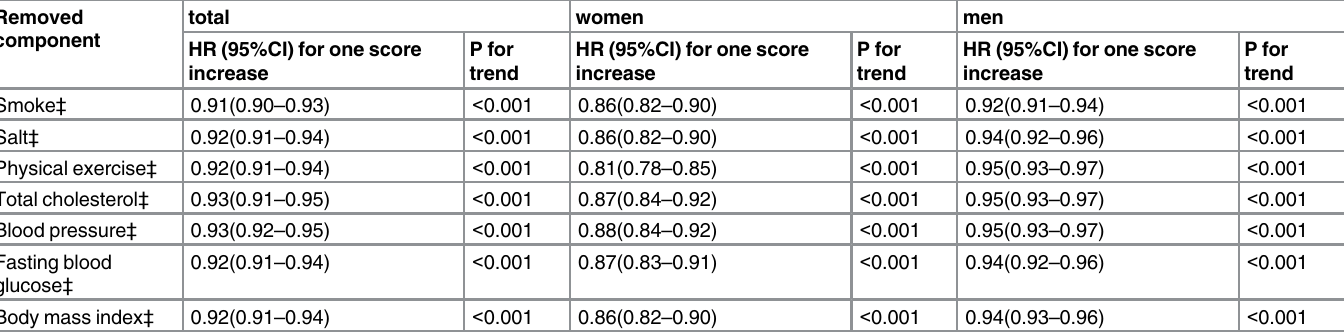
Table 5. Hazard ratios (HRs) and 95% confident intervals (95% Cis) of hypertension according to change of cardiovascular health scores ( 4 CHS) from 2006 to 2008, after one individual cardiovascular health is removed from the total score. Removed component